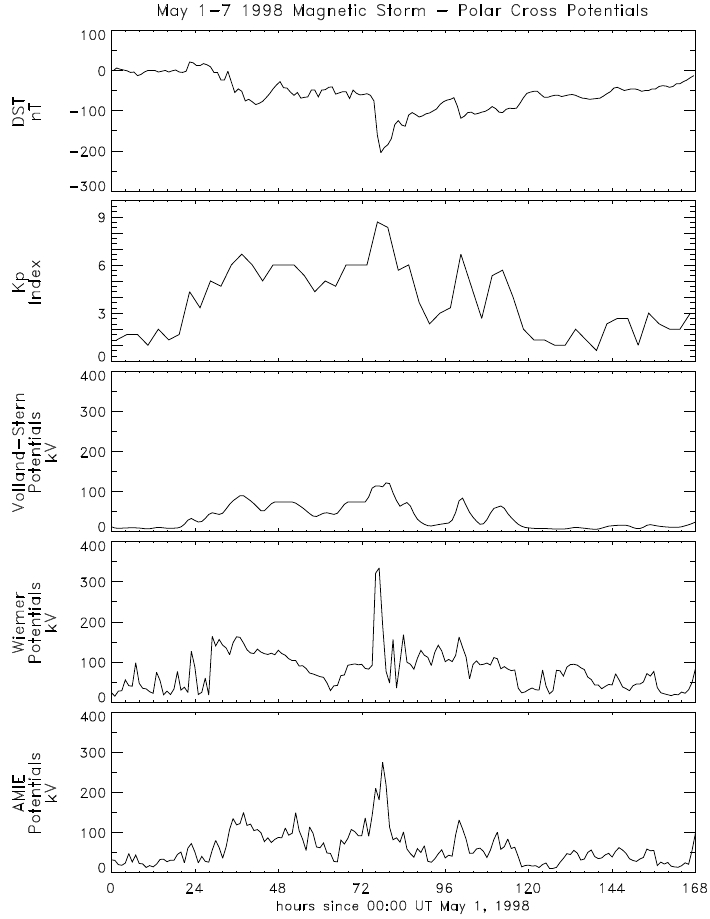
Fig. 1. Geophysical quantitites during the 1–7 May 1998 magnetic storm. The first two rows are the D st and K p global indices. The next three panels show the total cross-tail potential differences during the 4 May 1998 storm from the Volland-Stern model, the Weimer-96 model, and the AMIE